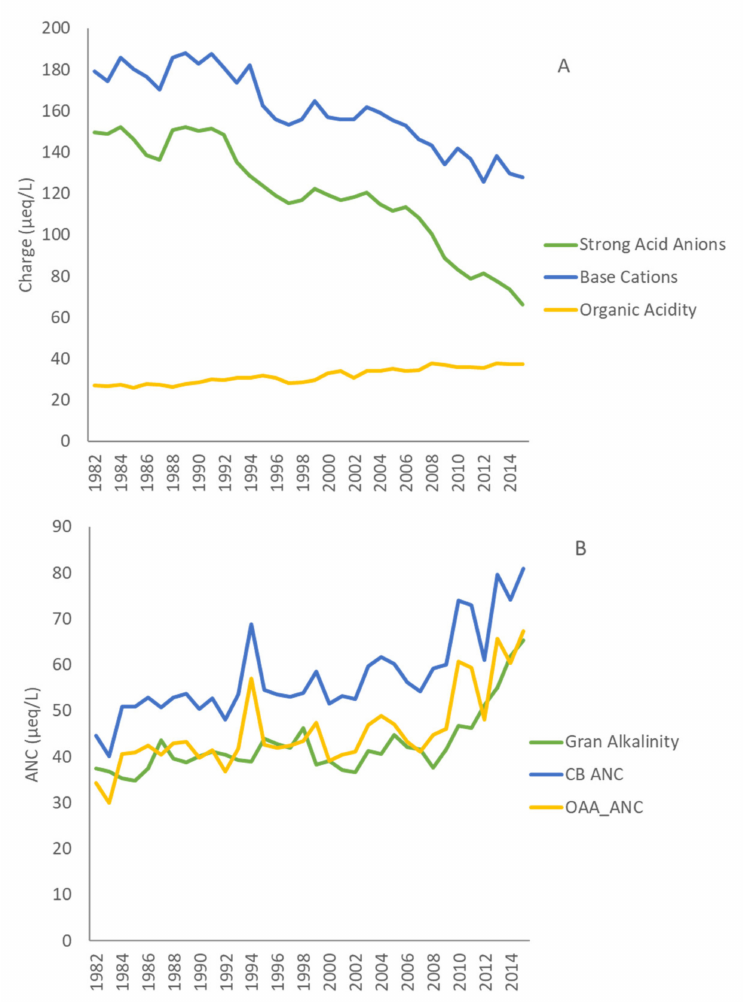
Figure 4. Mean values of the sum of strong acid anions (SO 4 + NO 3 + Cl), base cations and calculated organic acidity in the seven study lakes ( A ), and mean Gran alkalinity, charge balance acid neutralizing capacity (ANC) and organic acid adjusted ANC ( B ), between 1982 and 2015, in the seven study lakes. Dissolved organic carbon concentrations were between 2.0 and 6.0 mg L increased significantly over the study period (Figure 3d). The increase in DOC, however, was quite − 1 − 1 modest ( < 0.03 mg L yr ; Table 2), and changes in organic acid adjusted-ANC mirrored changes